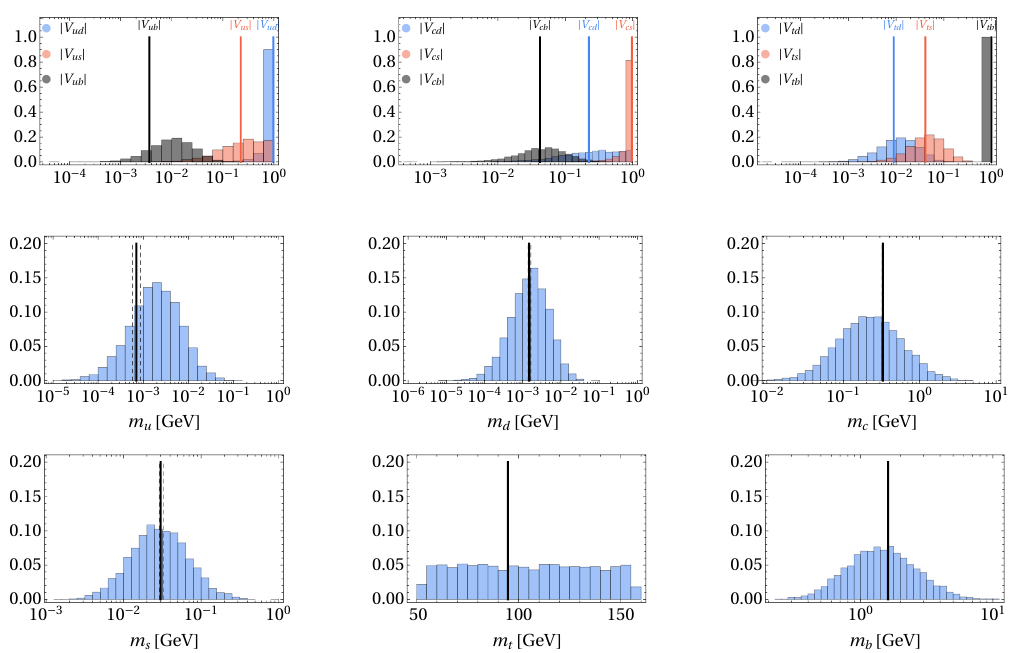
Figure 6 . Distributions of the CKM matrix elements and quark masses for inverted FN model with the G FN = U(1) 3 gauge group, see text for details. The vertical solid (dashed) lines mark FN the SM values (1 (cid:27) bands) for the observables at (cid:22) = 10 7 GeV.